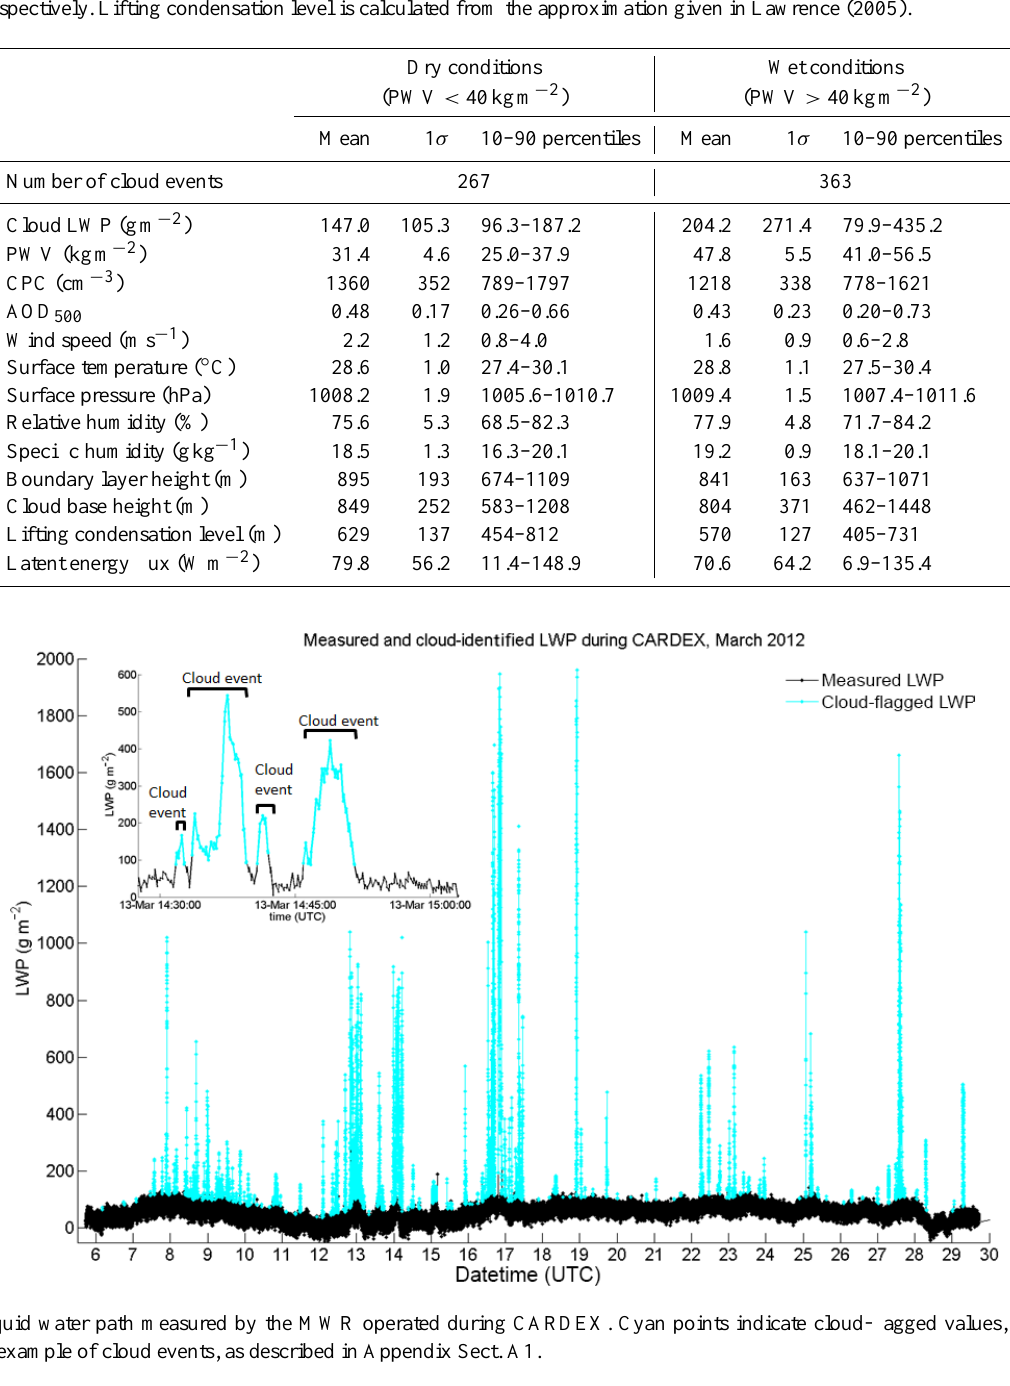
Table 3. Average surface values, standard deviations, and 10th and 90th percentile ranges observed for wet vs. dry conditions during CARDEX. Note the highly non-normal distributions of many of these parameters. With the exception of LEF and cloud values, these are calculated from the minute-averaged values for which PWV < 40 or PWV > 40kgm − 2 . The LWP and cloud base heights shown are the more meaningful averages over cloud events only; boundary layer height additionally follows this definition to illustrate the position of cloud relative to the boundary layer. Eddy covariance calculations require a 30min averaging period; additionally, eddy covariance fluxes were unresolvable during nighttime due to the low wind speeds. Thus, the values of LEF below are for 30min averaged daytime fluxes (06:00–18:00MVT) only. The corresponding 24h values are 74 . 8 ± 54 . 3 (6.0–137.3) and 67 . 6 ± 64 . 1 (3.4–133.7)Wm − 2 for dry and wet conditions, respectively. Lifting condensation level is calculated from the approximation given in Lawrence (2005).